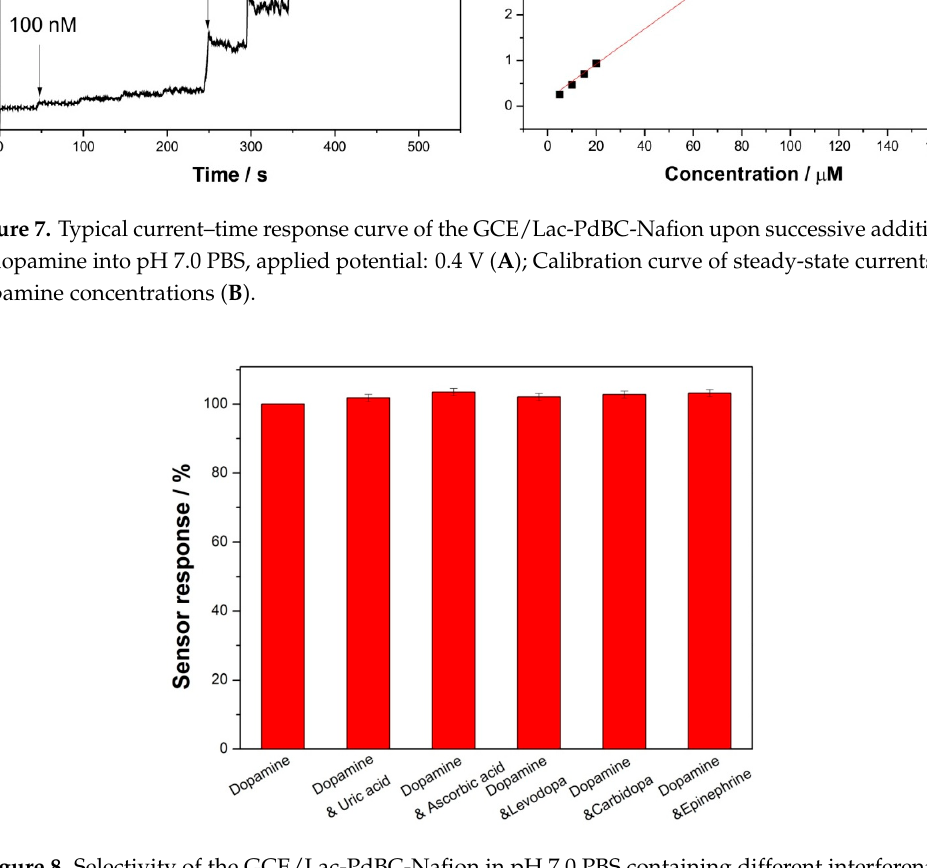
Figure 7. Typical current–time response curve of the GCE/Lac-PdBC-Nafion upon successive additions of dopamine into pH 7.0 PBS, applied potential: 0.4 V ( A ); Calibration curve of steady-state currents vs. dopamine concentrations ( B ). Table 1. Sensing performance comparison of different sensors toward dopamine.